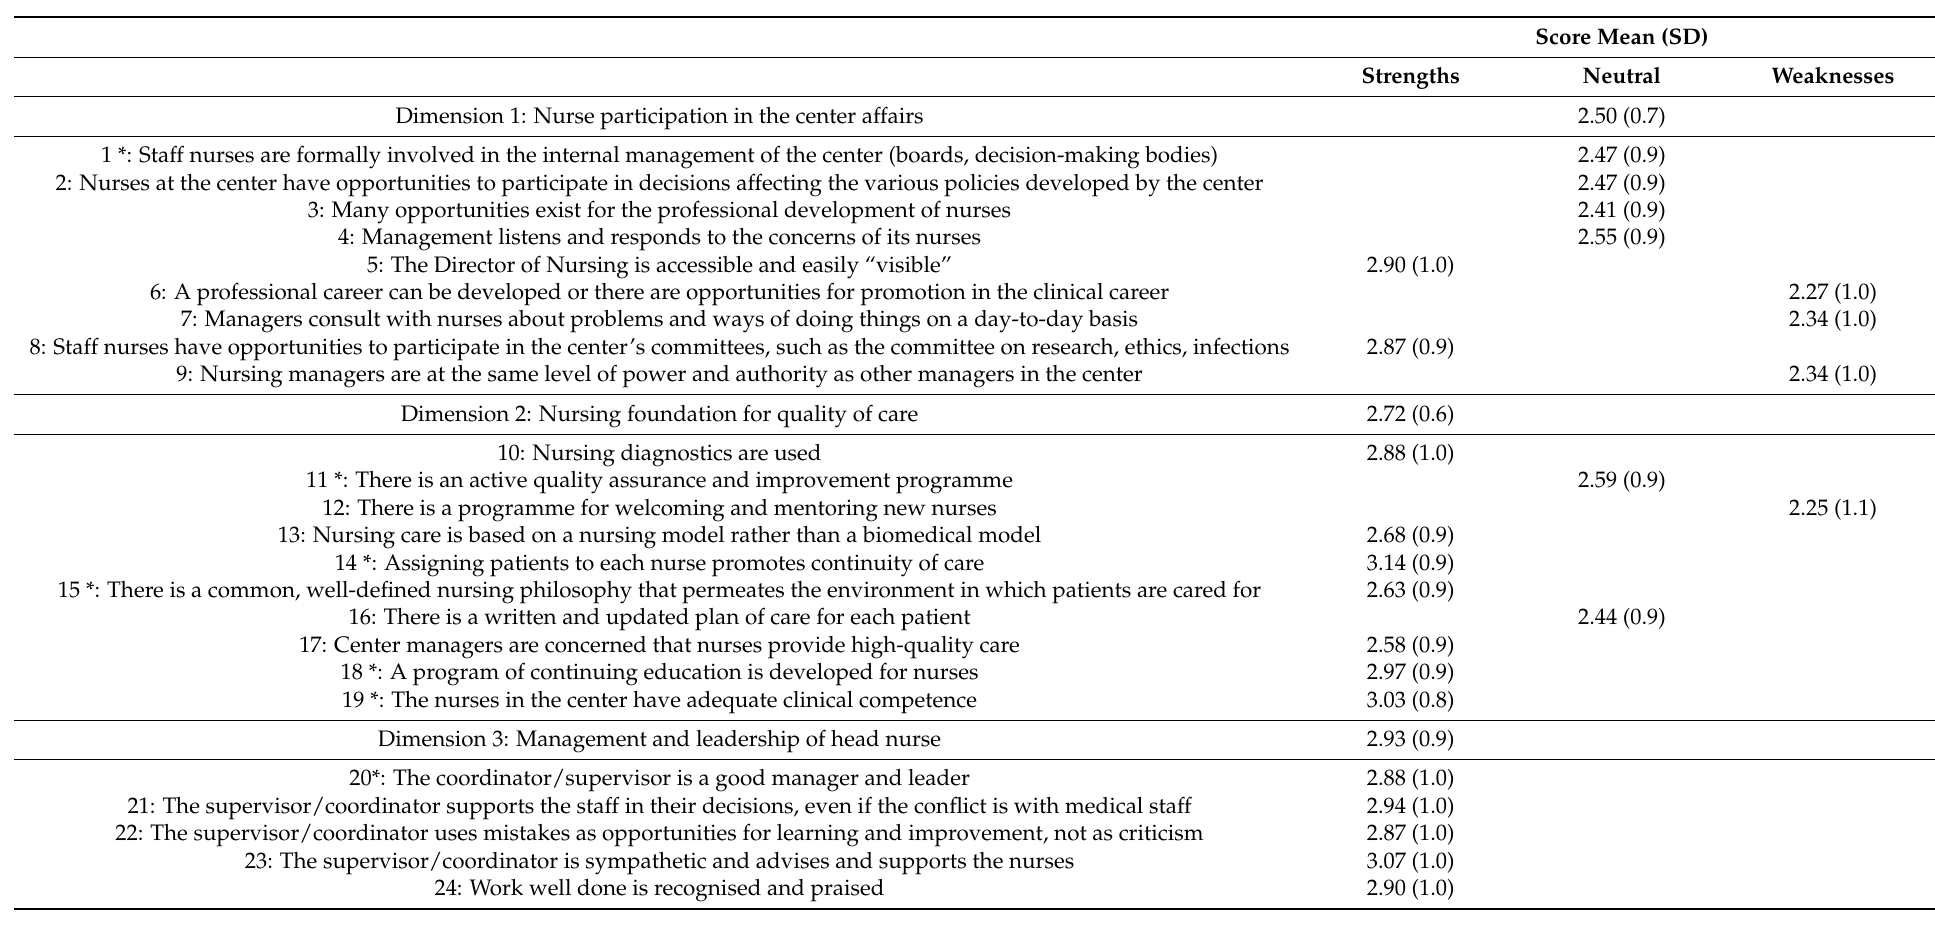
Table 1. Total scores by dimensions and items from the